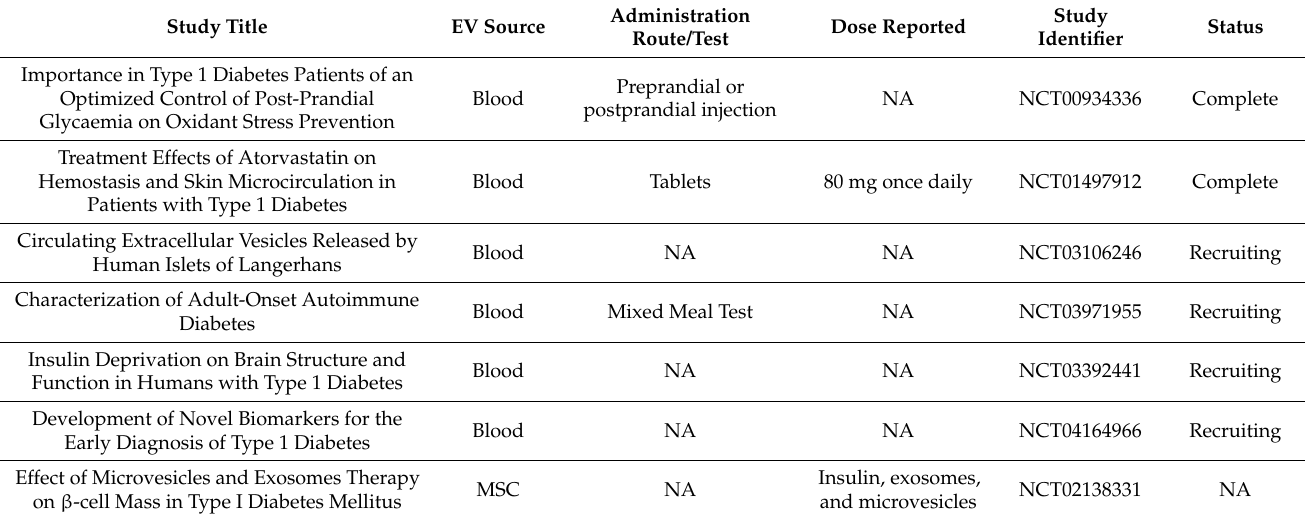
Table 6. EV-based clinical trials in